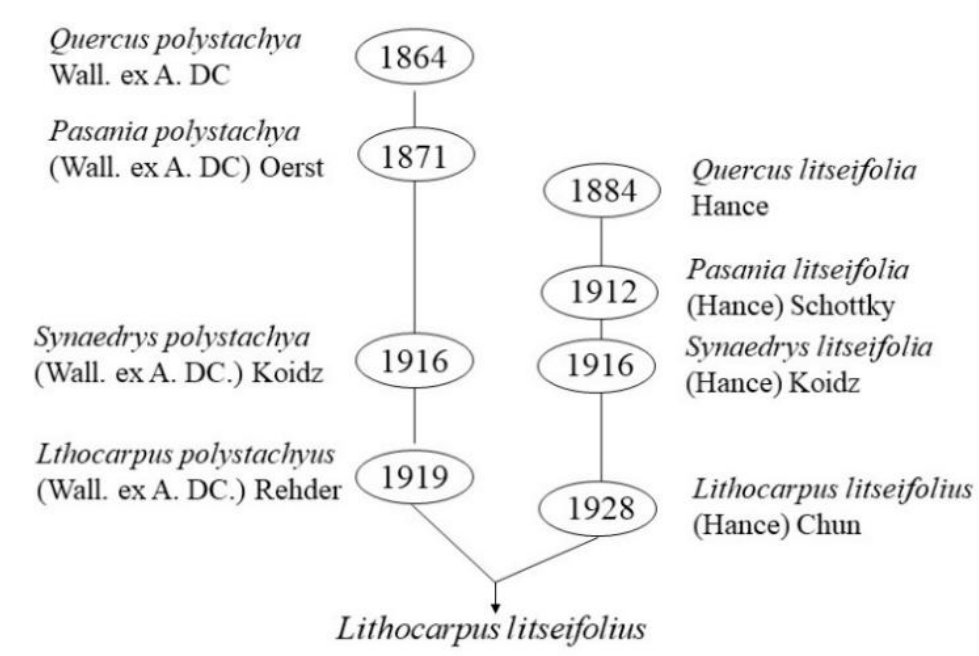
Figure 1. The change of scientific name of the sweet tea. Table 1. Effect of the location, picking time and leaf maturity on the content of DHCs in the sweet